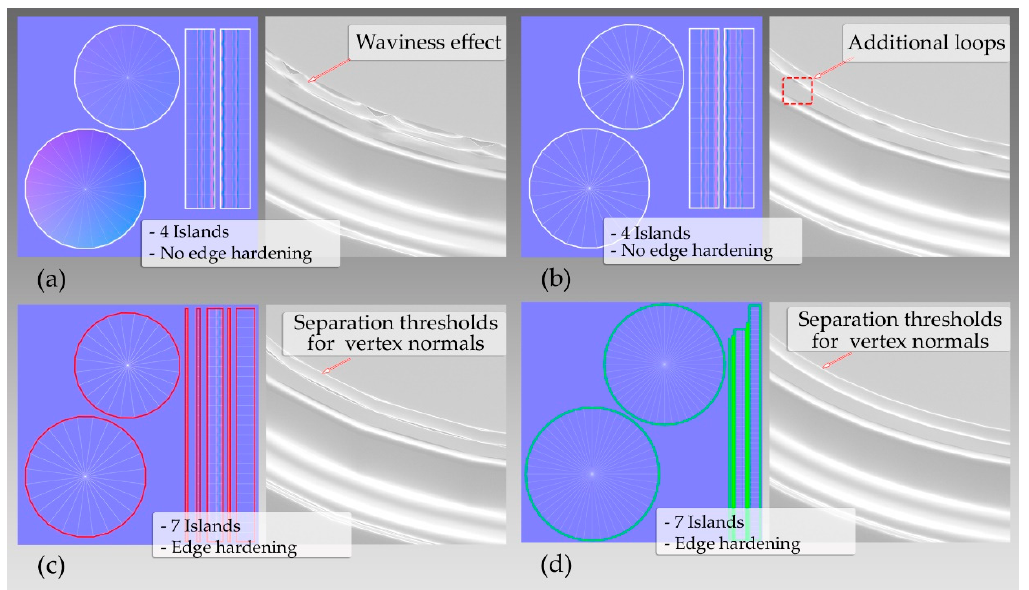
Figure 16. ‘Waviness’ effect on cylindric and ‘hard-box’ models ( a ); additional loops of edges do not solve the problem ( b ); edge hardening on ( u,v ) island boundaries improves the visual quality ( c ); increased amount of polygons can solve the problem in combination with edge hardening ( d ).